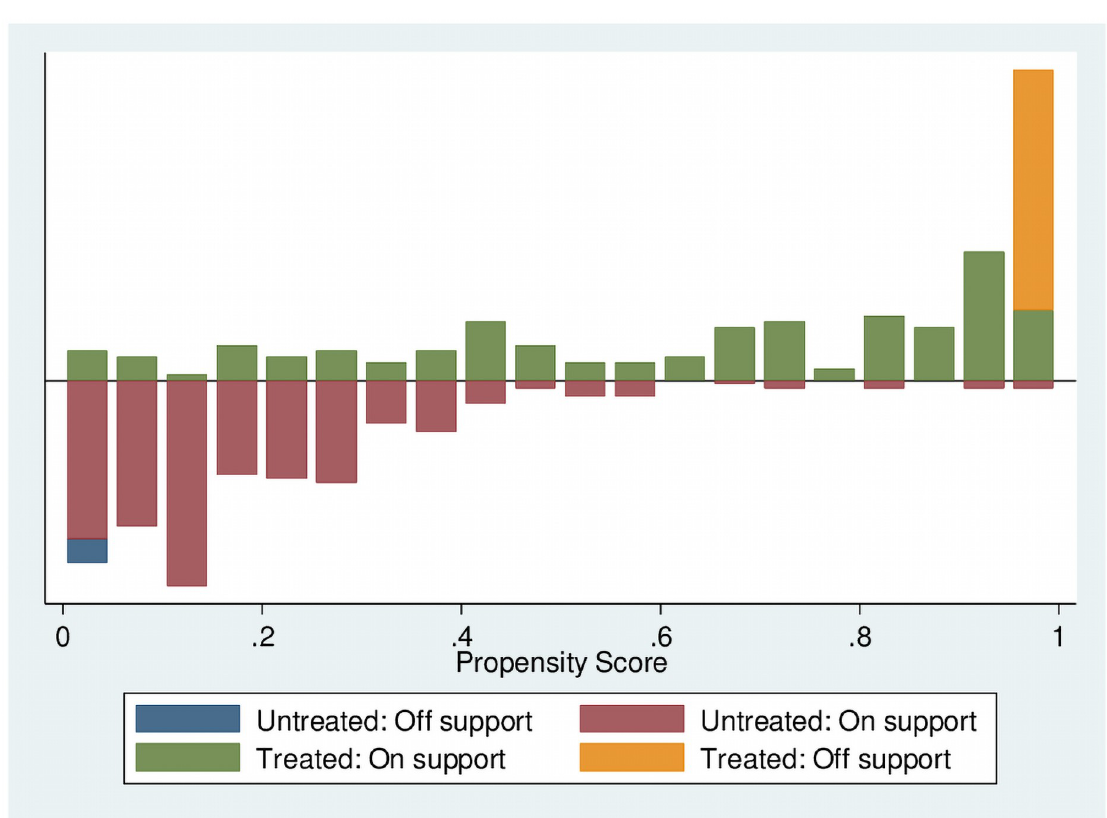
Fig 4. After matching of renting-out